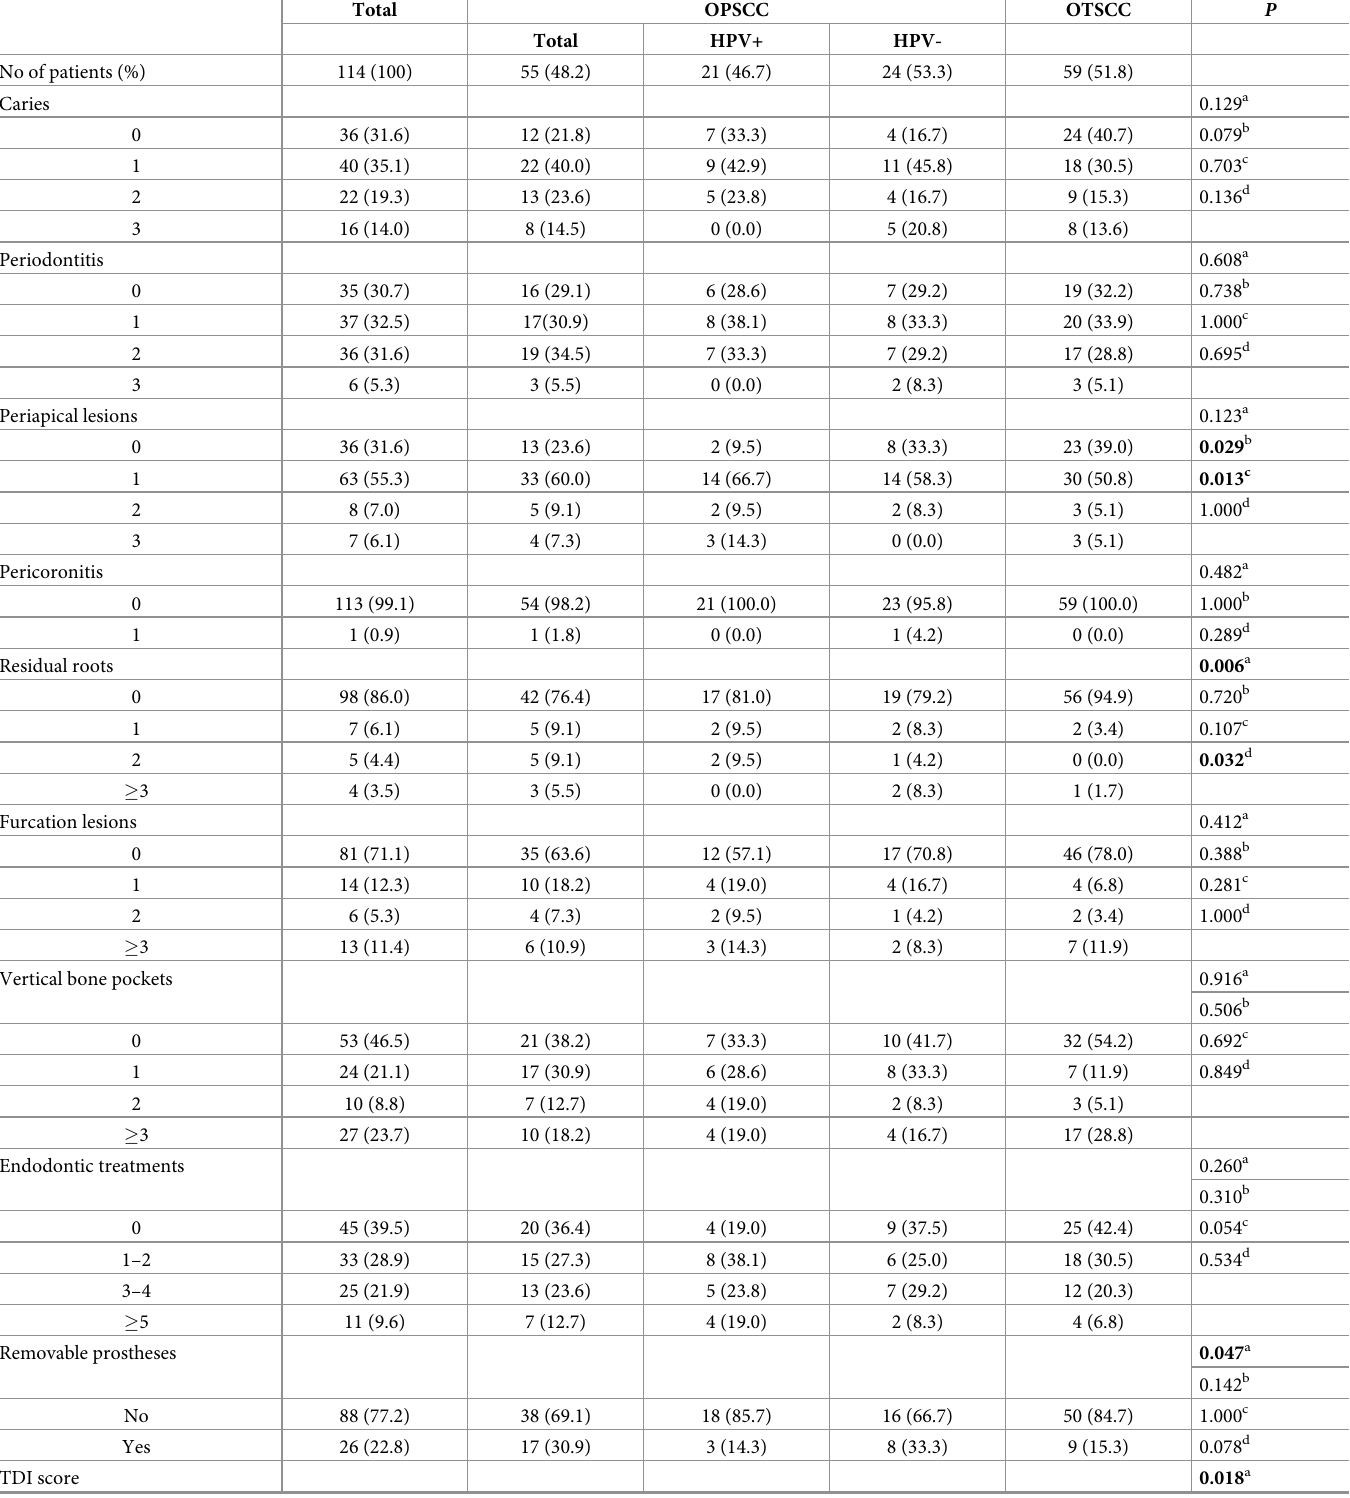
Table 2. Dental indexes of the study population with oropharyngeal (OPSCC) and oral tongue (OTSCC) squamous cell